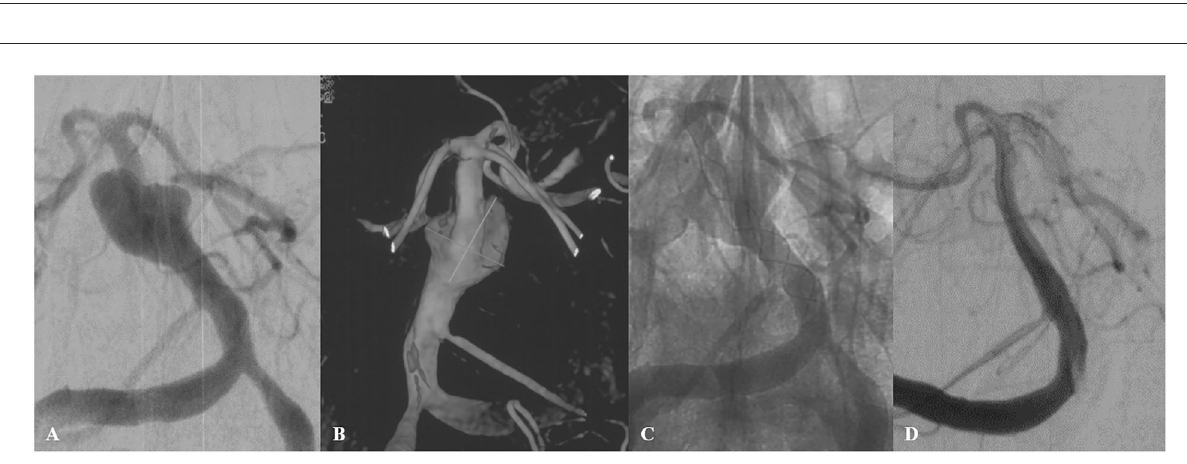
FIGURE2 A 56-year-old male patient (Case 10) with a large basilar trunk aneurysm presented with dizziness. Preoperative angiography (A) with 3-dimensional reconstruction (B) demonstrated an irregular dissecting aneurysm at the middle basilar trunk. A single Tubridge device was placed in the basilar trunk (C) . 10-month follow-up angiography demonstrated complete obliteration of the aneurysm (D)